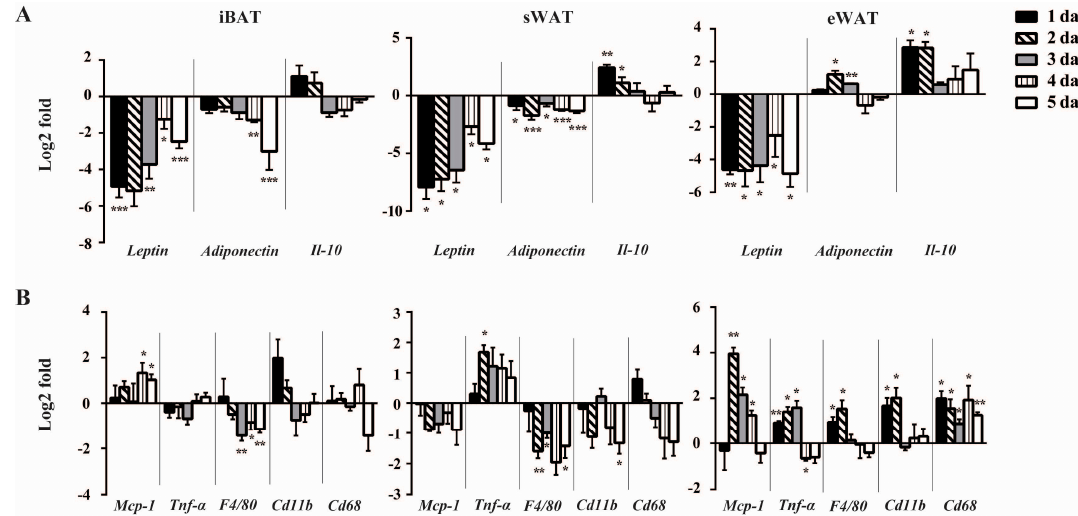
Figure 2. Cold exposure differentially alters the expression of inflammatory adipokines among adipose tissues. Quantitative PCR analysis of anti-inflammatory ( A ) and pro-inflammatory ( B ) adipokines genes expression in iBAT, sWAT and eWAT of control mice and mice exposed to Cold (4 °C) up to 5 day. The data show the fold changes of the expression for the target genes in iBAT, sWAT and eWAT of RT and Cold mice ( n = 6 for each group). Values are mean ± S.E.M. and expression of genes is corrected for the housekeeping gene Cyclophilin . All the data were normalized to the expression in RT mice respectively to show the cold-induced gene expression differences. Erected bars: genes up-regulated and inverted bars: genes down-regulated compared to the RT mice. (* p < 0.05, ** p < 0.01, *** p < 0.001).